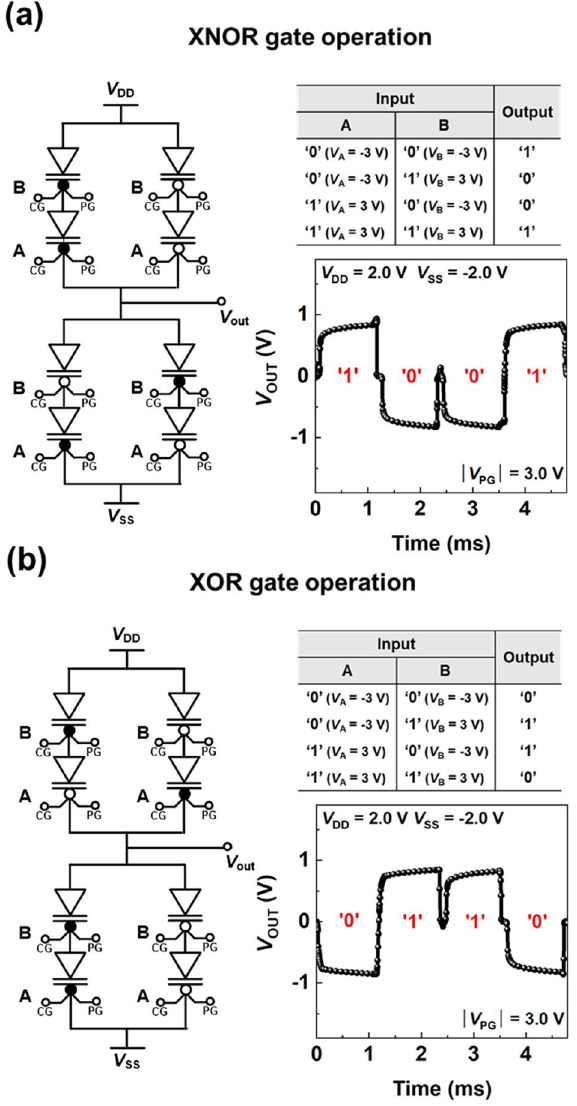
Figure 3. Universal logic-in-memory (ULIM) cell demonstrating XNOR/XOR logic gate operations. Circuit diagrams, truth table, and timing diagrams for ( a ) XNOR and ( b ) XOR logic gate